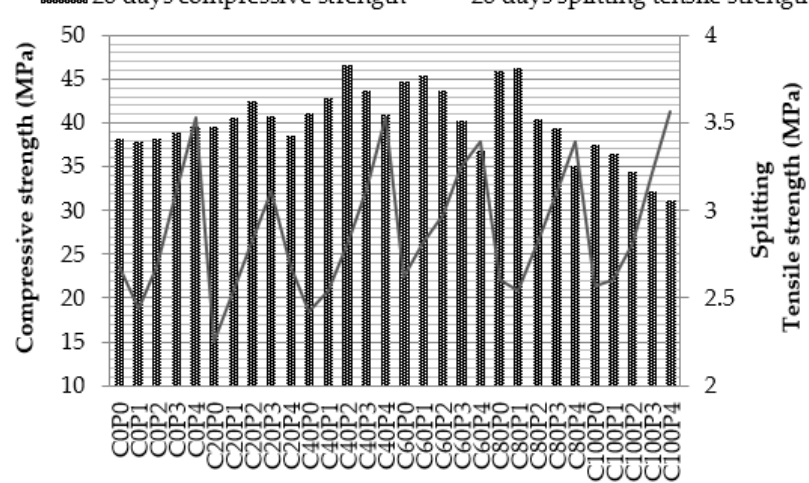
Figure 5. Compressive strength and tensile strength of concrete.